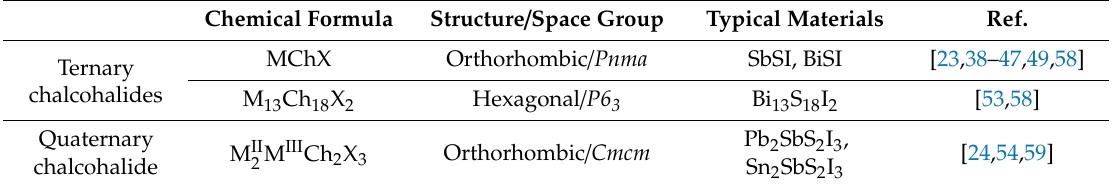
Table 2. Summarized data for the structural properties of Sb / Bi chalcohalides used for solar cells. Chemical Formula Structure / Space